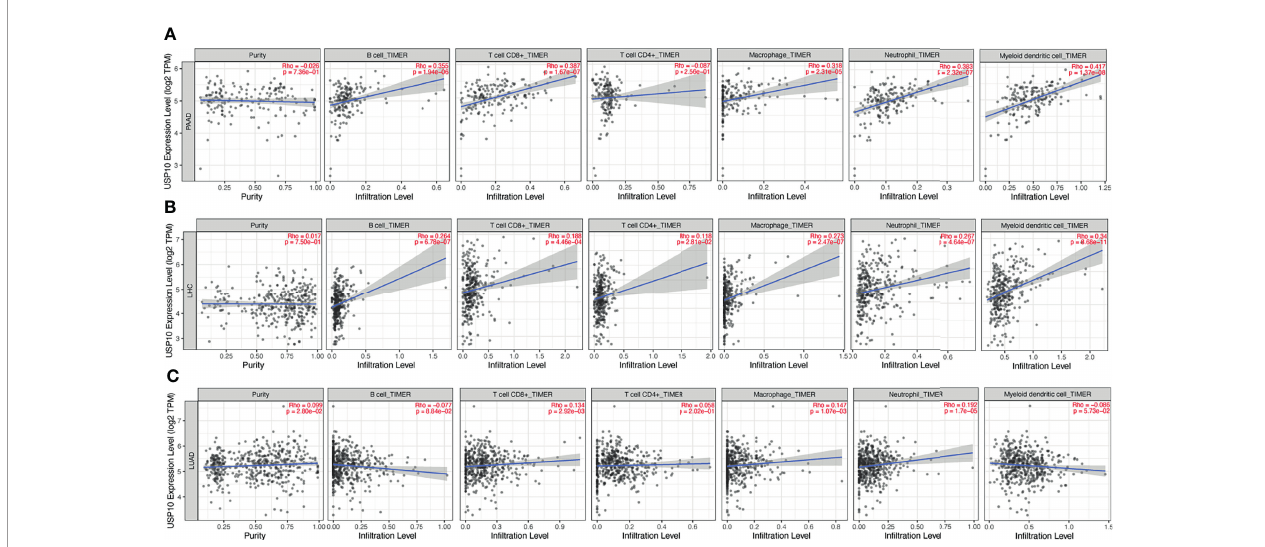
FIGURE 8 | TIMER database analysis of the correlation between USP10 expression and immune in fi ltration level in LUAD, LIHC, and PAAD. (A) In PAAD, USP10 expression was not related to tumor purity, but correlated signi fi cantly and positively with in fi ltration levels of dendritic cells, neutrophils, macrophages, CD8+ T cells, and B cells. (B) In LIHC, USP10 expression was not related to tumor purity, but correlated signi fi cantly and positively with dendritic cells, neutrophils, macrophages, CD4+ T cells, CD8+ T cells, and B cells. (C) In LUAD, USP10 expression correlated weakly with tumor purity and correlated signi fi cantly and positively with CD8+ T cells, macrophages, and neutrophils, but had no signi fi cant relationship with the immune in fi ltration of B cells, CD4+ T cells, and dendritic cells. PAAD, pancreatic adenocarcinoma; LIHC, liver hepatocellular carcinoma; LUAD, lung adenocarcinoma. Signi fi cance is indicated by a P -value <